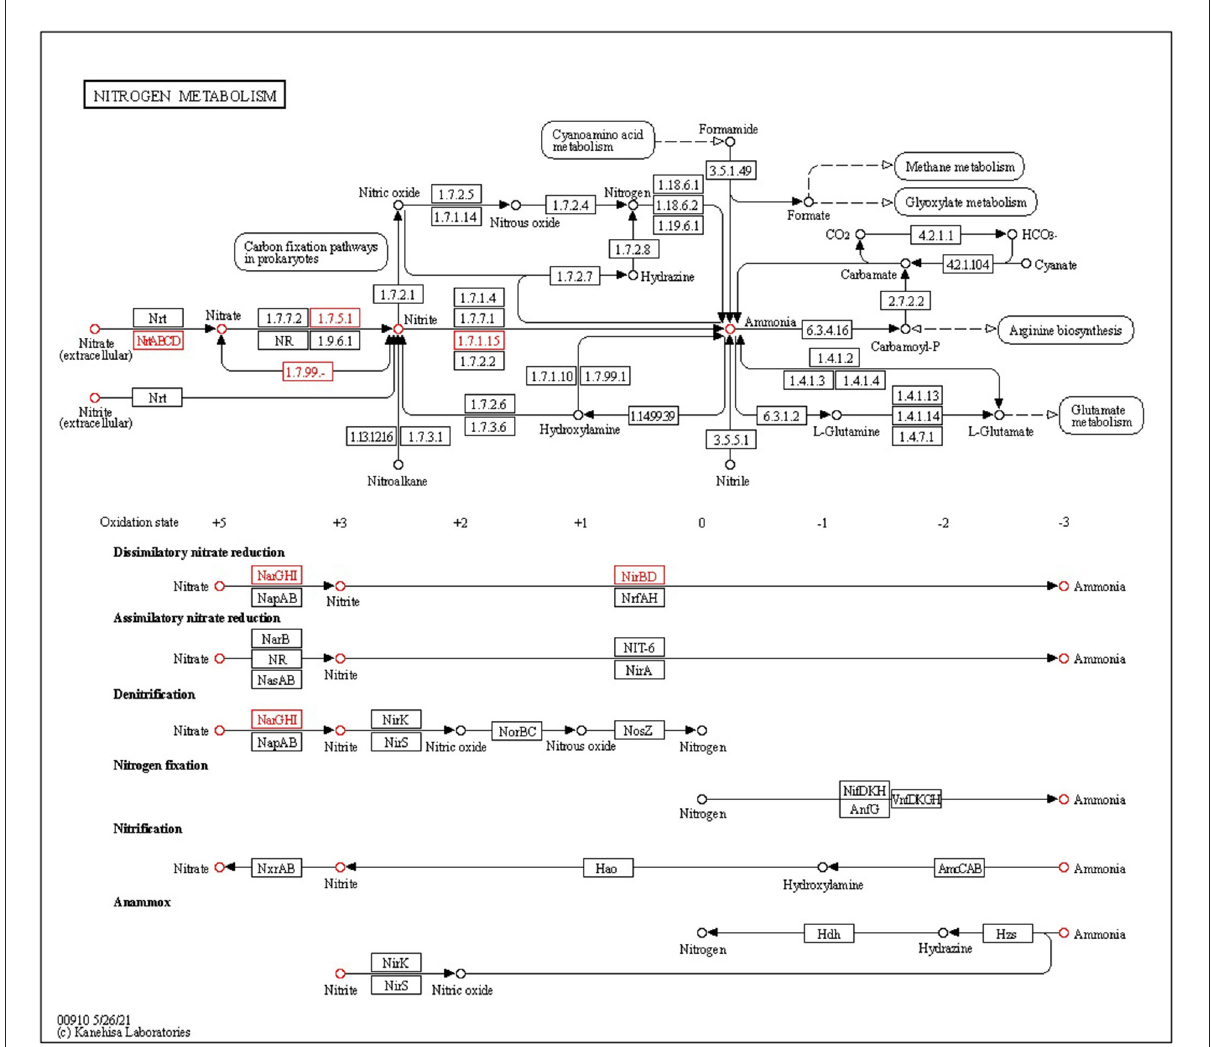
FIGURE7 KEGG pathway gene mapping of the strain CPHN2 for nitrogen